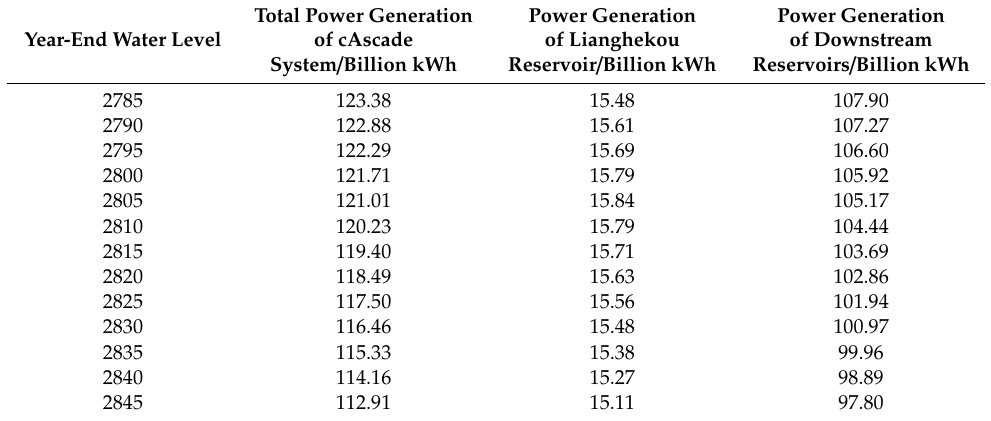
Table 4. Calculation results of wet year under di ff erent year-end water levels of Lianghekou